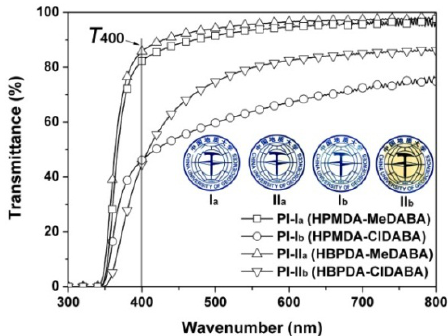
Figure 6. UV–Vis spectra of PI films. Insert: appearance of PI films. Table 2. Optical and thermal properties of PI